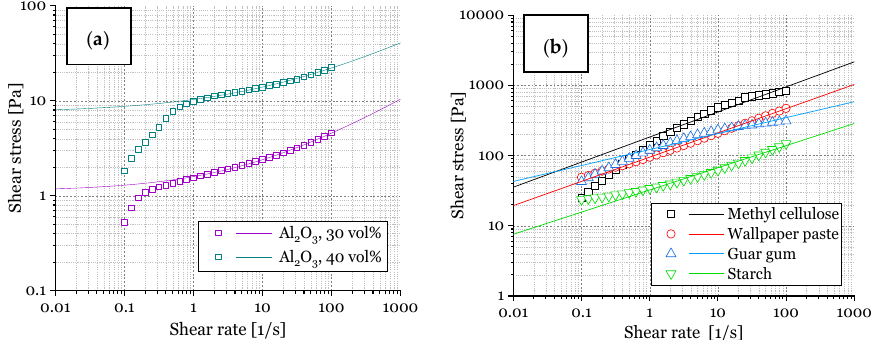
Figure 2. Shear stress vs. shear rate: ( a ) of alumina dispersions (30 vol% and 40 vol%) in water with the additives binder and deflocculant (solid lines represent a fit via the Herschel–Bulkley-model); ( b ) thickening agents dissolved in water (solid lines represent a fit via the Power-Law model), see Table 1.